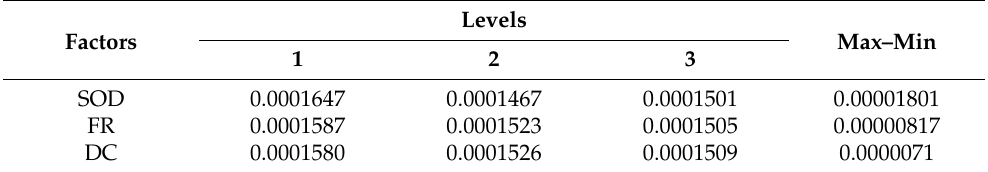
Table 5. Computation of optimal parameter combination.